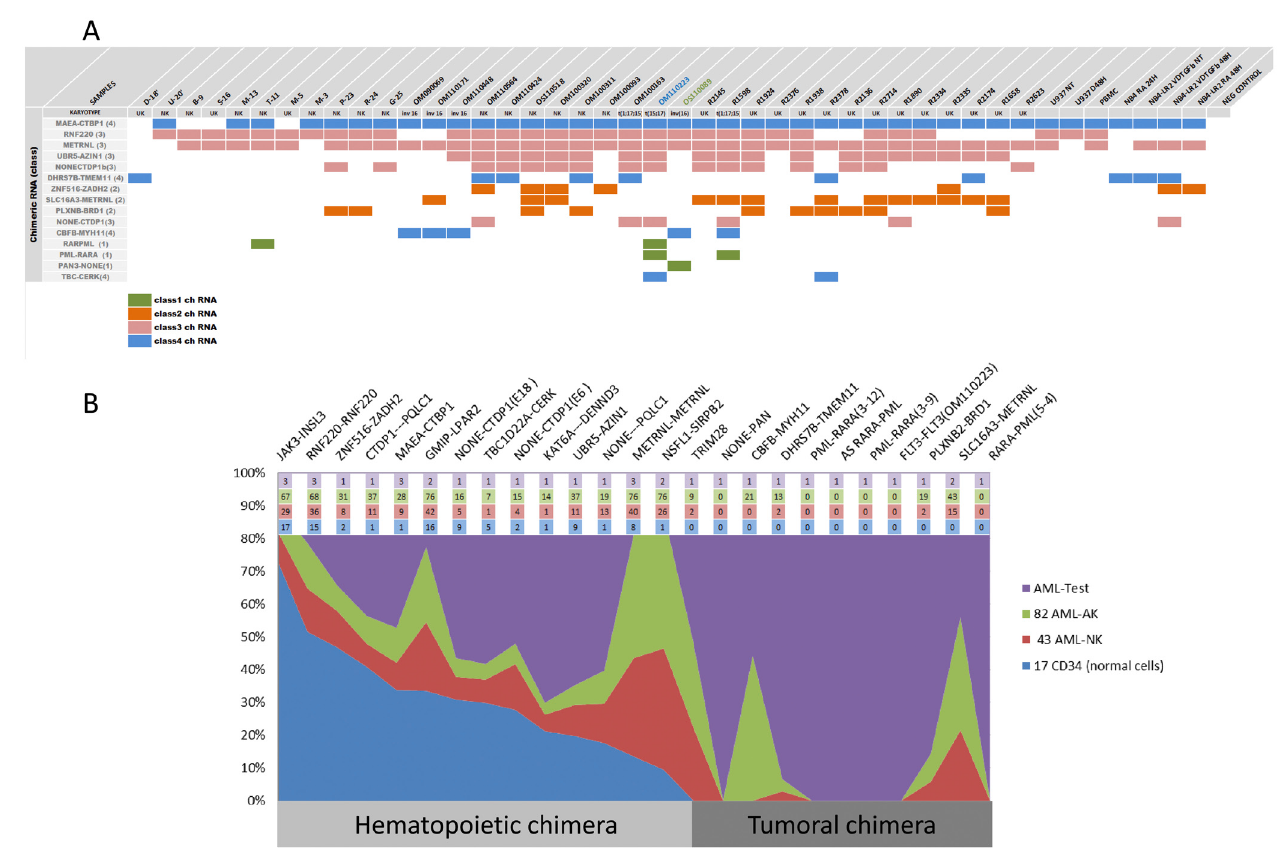
Figure 5. Chimeric RNA recurrence screening. ( A ) Expression of validated chRNA in a large AML cohort. ChRNA classes are identified by colours (green for Class 1, orange for Class 2, red for Class 3 and blue for Class 4). Karyotypes are indicated below the sample name (UK for unknown karyotype, NK for normal karyotype). For abnormal karyotype, chromosomal rearrangement is indicated. The screening was also performed on not treated (NT) or differentiated cell lines. For PML-RARA and CTDP1 exons involved in the chRNA are indicated. ( B ) Classification of chRNA depends on normal or tumor level expression. ChRNA expression, in normal CD34+ HSCs (CD34) and in AML (LEUCEGENE data), is presented using the tag search approach. For each group (AML-test, AML-AK, AML-NK, CD34), samples displaying a positive chRNA tag count are selected. The average tag expression is calculated with the selected samples and chRNA classified by their relative expression in the CD34 group. The table with highlighted colour indicates for each chimera, within the different cohort, the number of samples presenting the